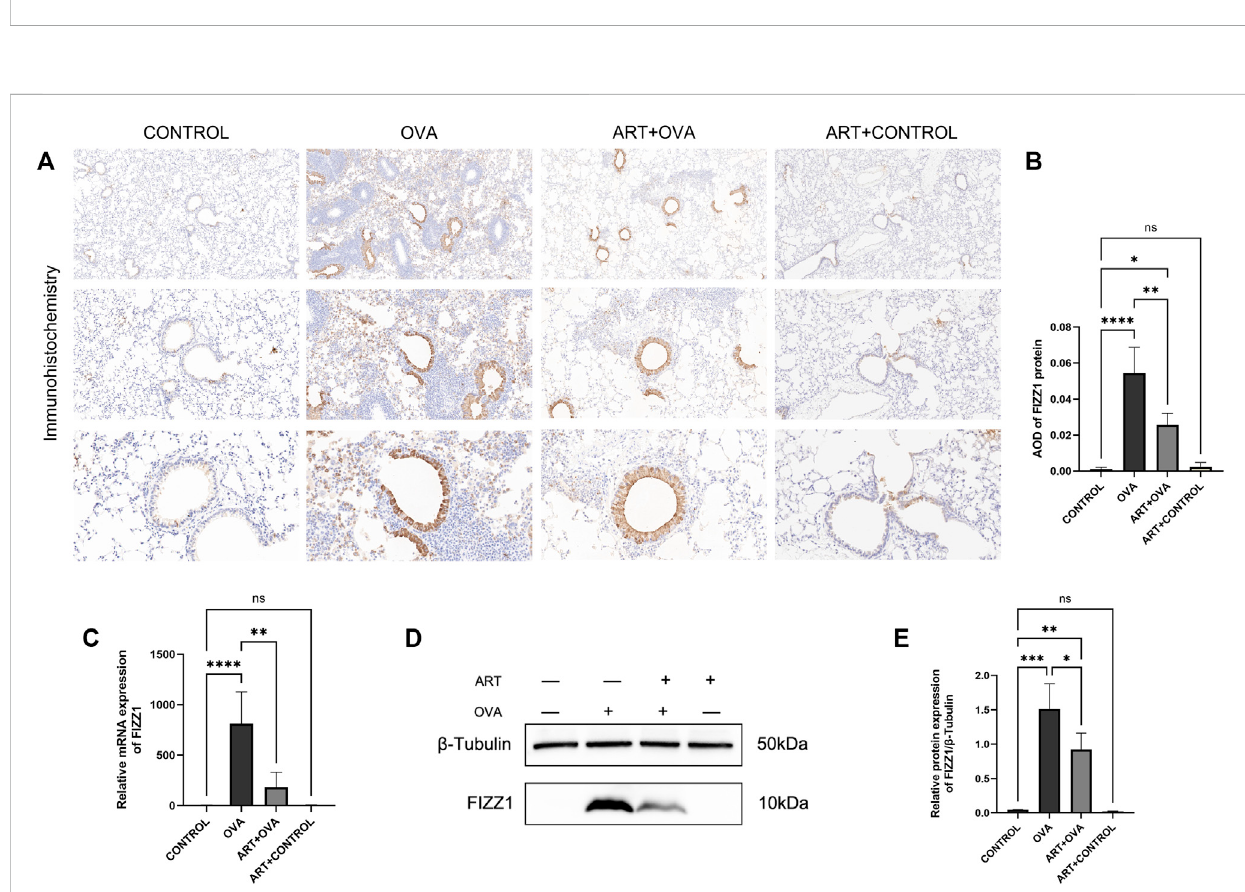
FIGURE 8 EffectofARTonFIZZ1inOVA-inducedasthmamice. (A) RepresentativeimmunohistochemistryphotographsofFIZZ1( n =6)(Imageswerecaptured at ×100, ×200, and ×400 magni fi cation). (B) The results are expressed as mean ± SD. AOD, average optical density. (C) Relative mRNA expression of FIZZ1 in four groups: control, asthma (OVA), ART + asthma (ART + OVA), and ART + CONTROL group ( n = 6). (D, E) Western blot analysis of FIZZ1 ( β - Tubulin was used as protein loading control) in the lungs from each group ( n = 3). * p < 0.05, ** p < 0.01, *** p < 0.001, **** p <